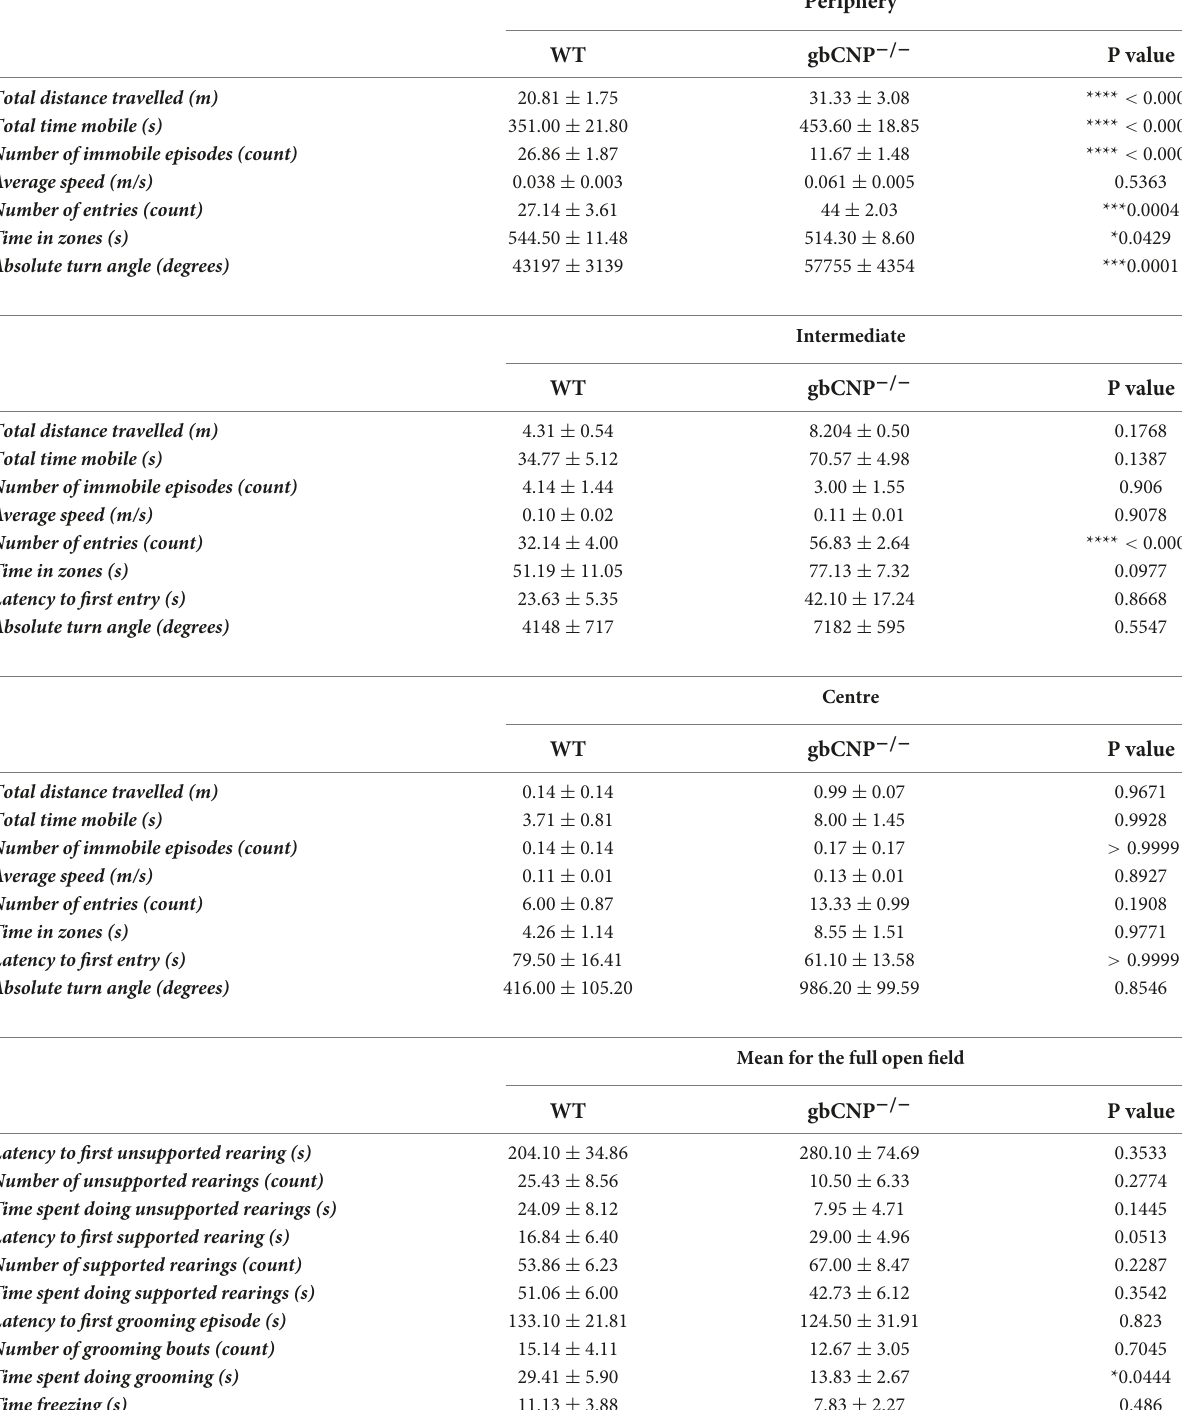
TABLE 3 Open field behavior in wild-type and global CNP knockout mice.